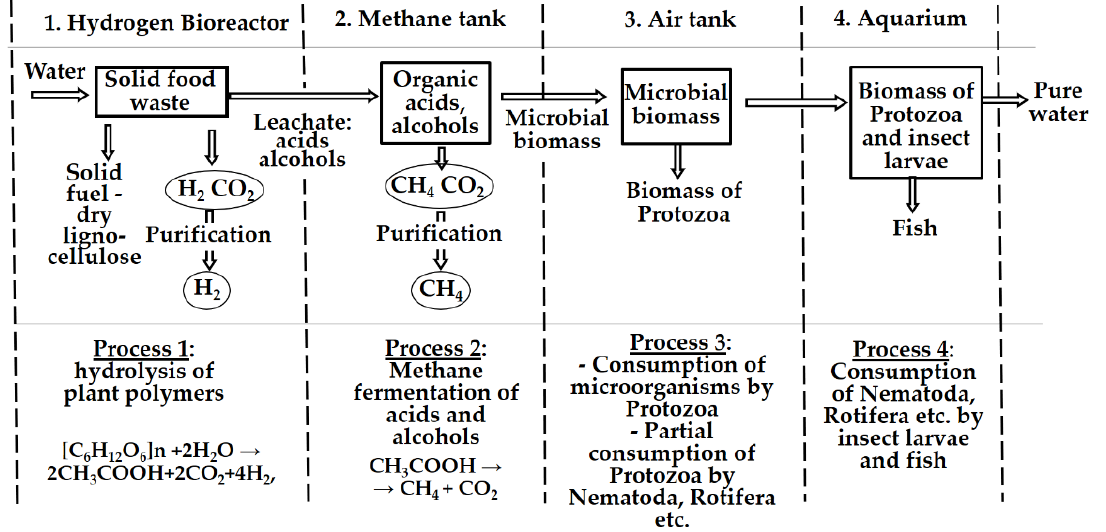
Figure 3. The summary of biological processes in the modular flow installation used in this study.